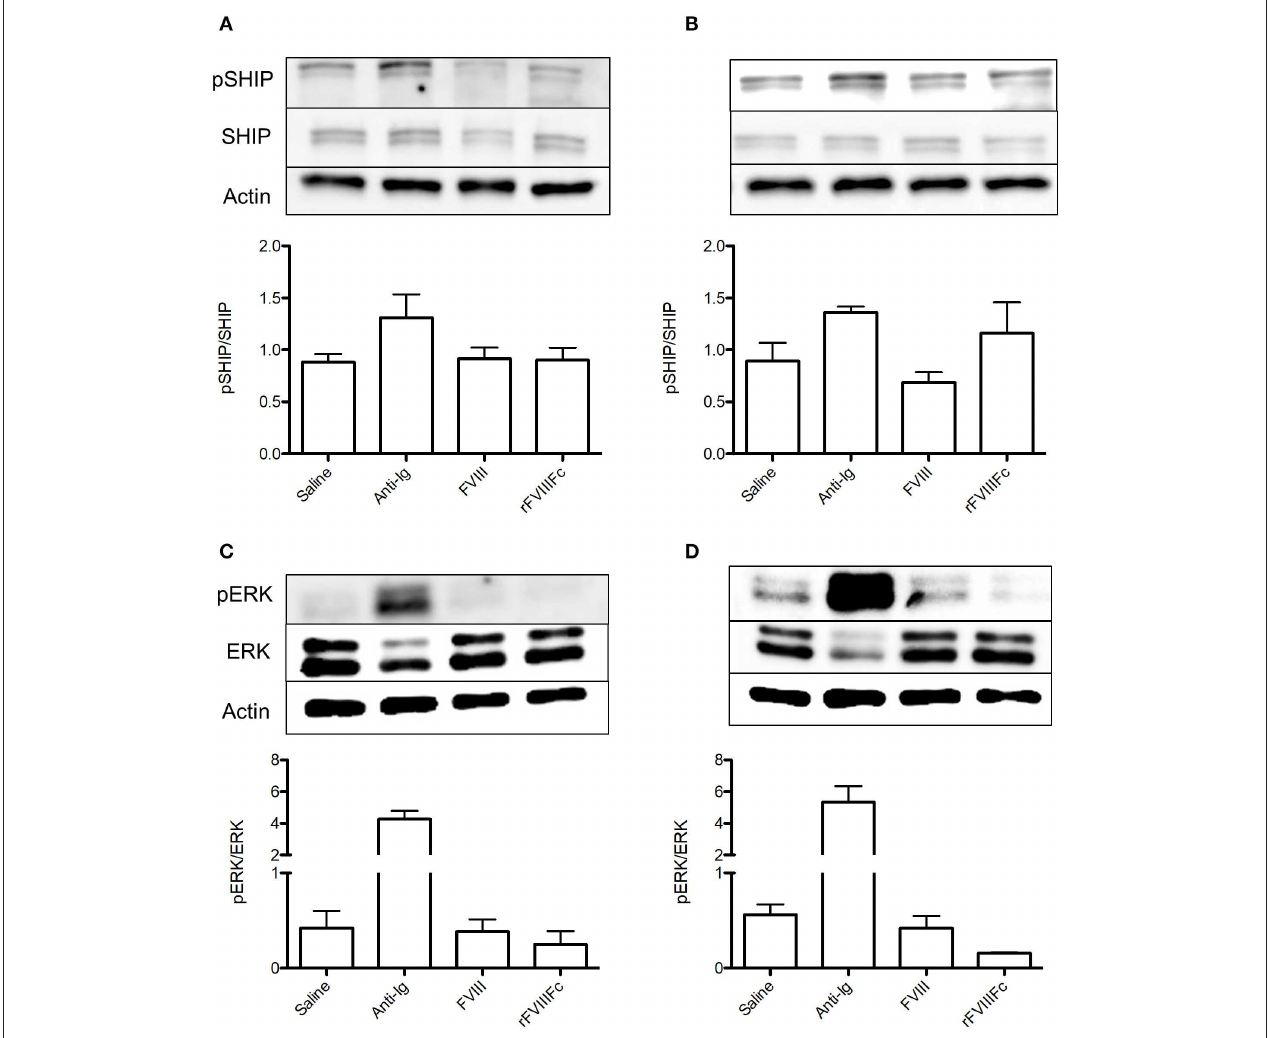
FIGURE 4 | rFVIIIFc induces inhibitory signaling in FVIII-exposed but not naïve B cells. pSHIP and pERK levels in saline, anti-Ig (20 µ g/ml), FVIII (11.4 µ g/ml), and rFVIIIFc (14.7 µ g/ml) stimulated (A,B) naïve and (C,D) FVIII-exposed B cells. Ratios of phosphorylated to total protein were obtained through densitometry analysis of three different blots. n = 3/condition. Error bars represent